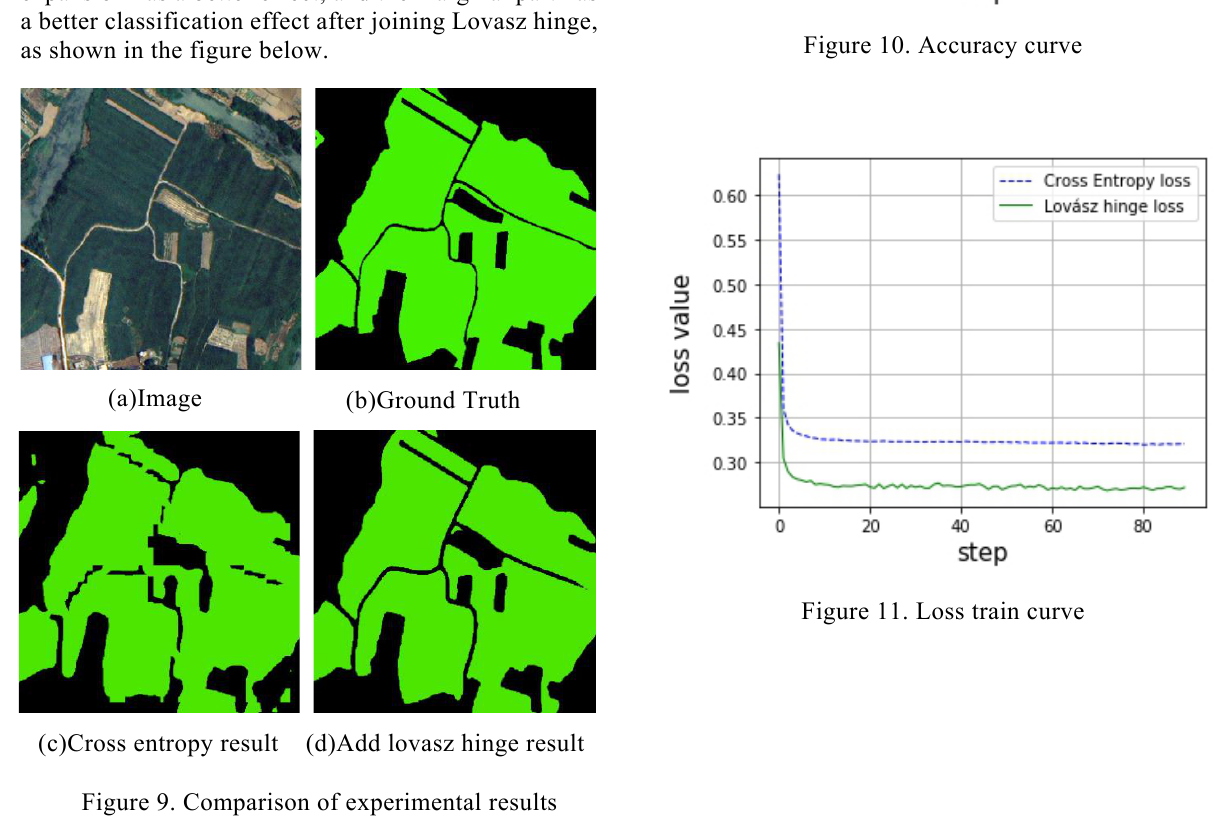
Figure 9. Comparison of experimental results